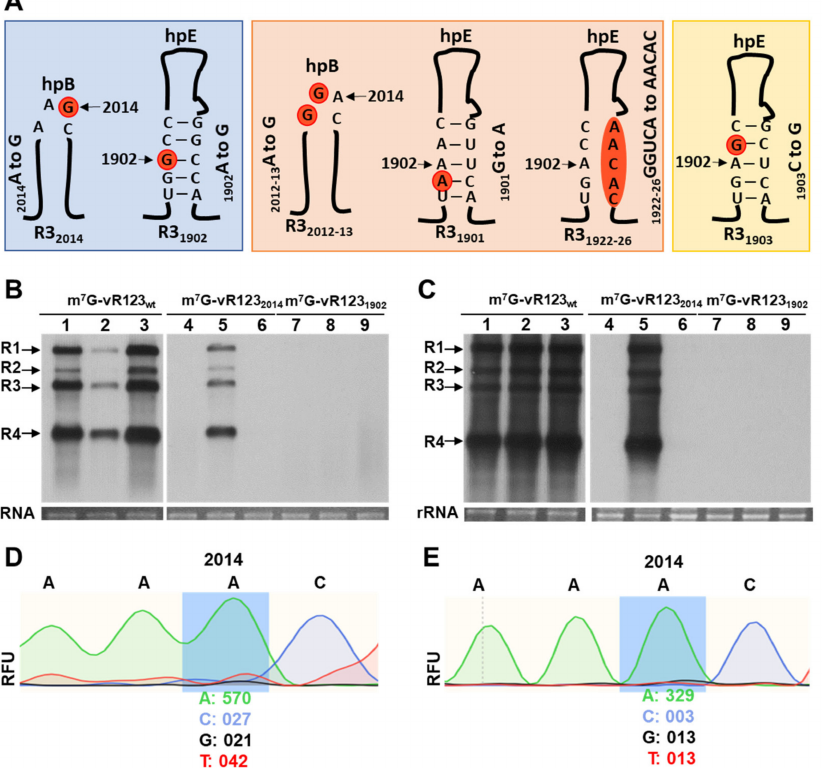
Figure 1. Schematic representation of the different mutations on hpB and hpE structures of the 3-UTR in the RNA 3 analyzed in this study and effect of mutations in DRACH motives in the 3 (cid:48) UTR-RNA 3, using RNA transcript inoculation procedure. ( A ): Mutant names are indicated at the bottom of each mutant. Mutated nucleotides are indicated in orange circles. In blue shading, mutant RNAs with the potential methylated A is substituted to G. In orange shading, RNAs with mutations around this A, but keeping a DRACH motif. In yellow shading, mutant RNAs in which A is conserved but DRACH is disturbed. ( B , C ): Representative Northern blots assays from inoculated ( B ) and upper non-inoculated leaves ( C ) of N. benthamiana plants at 6- and 13- days post-inoculation, respectively. Three plants were mechanically inoculated with different mixtures of the three RNAs plus CP (indicated at the top of the panels). Positions of the vRNAs are indicated on the left. Ethidium bromide staining of ribosomal RNAs was used as RNA loading control. ( D , E ): Representative electropherogram of the 2012 DRAC 2015 -motif, located in the hpB of the 3 (cid:48) UTR-RNA 3 in inoculated ( D ) and upper non-inoculated leaves ( E ) with m 7 G-vRNA123 2014 . RFU values (relative fluorescence units) of the A and G nucleotides are indicated at the bottom of the mutated